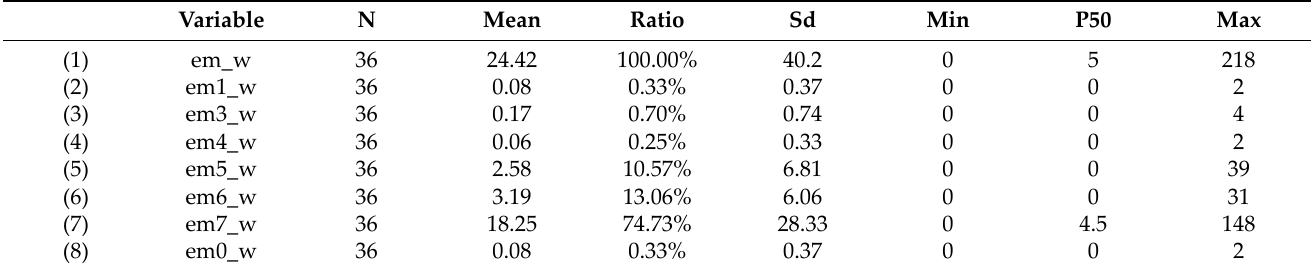
Table 5. Results of the analysis of the level‑2 employee subdimension on social media.